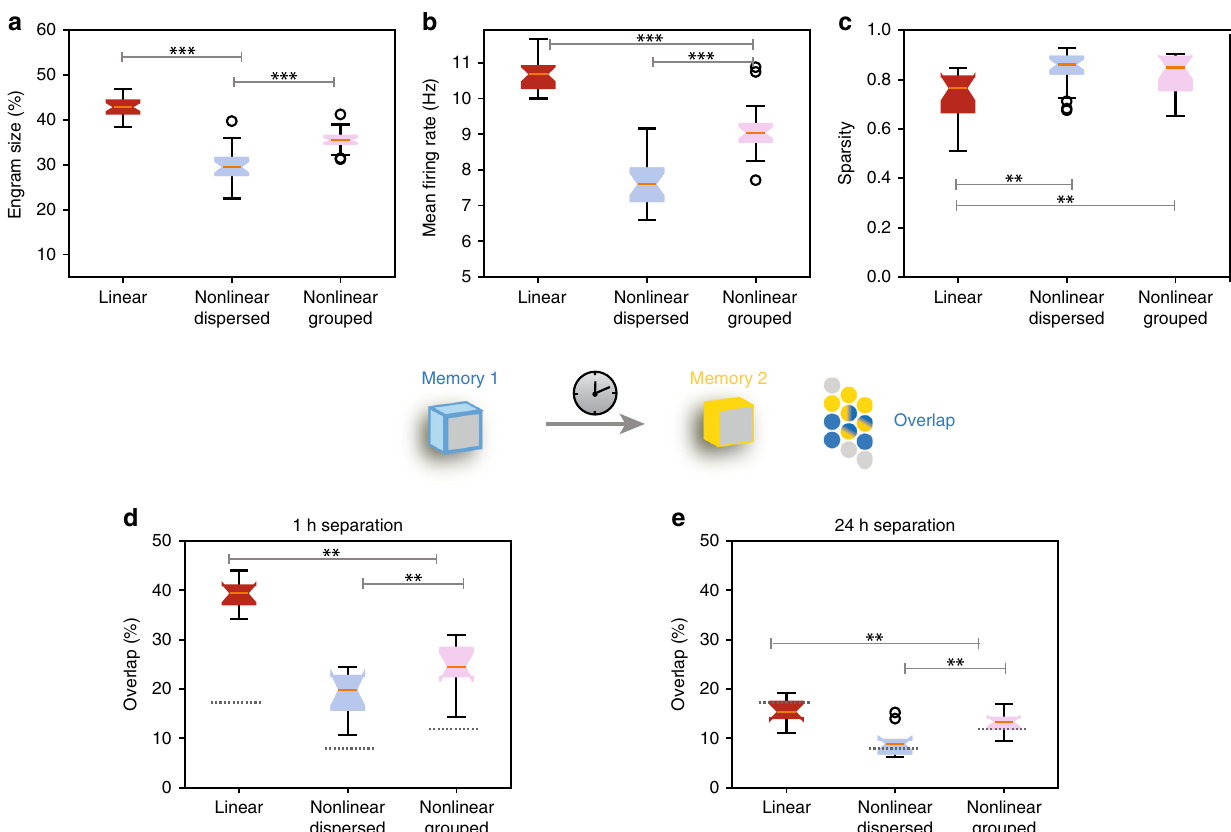
Fig. 7 Properties of memory engram encoding under different dendritic nonlinearity con fi gurations. a Size of memory engram (percentage of excitatory neurons that respond with ff > 10 Hz during memory recall) for Linear/Bi-modal FS-BC dendritic subunits receiving dispersed (light blue) or grouped (pink) synaptic inputs. b Mean fi ring rate of the excitatory population under the conditions enumerated in a . c Treves – Rolls sparsity metric of the excitatory population fi ring rates under the conditions enumerated in a . d Percentage of overlap between two memory engrams when two memories are separated by 1 h, under the conditions enumerated in b . Dashed lines indicate the chance level of overlap for the engram sizes of the dispersed case shown in a . e As in d for 24 h separation. Box plots indicate data from 20 simulation trials for a – c , and 10 trials for d – e . ANOVA **p < 0.05 , ***p < 0.005. Error bars indicate minimum and maximum